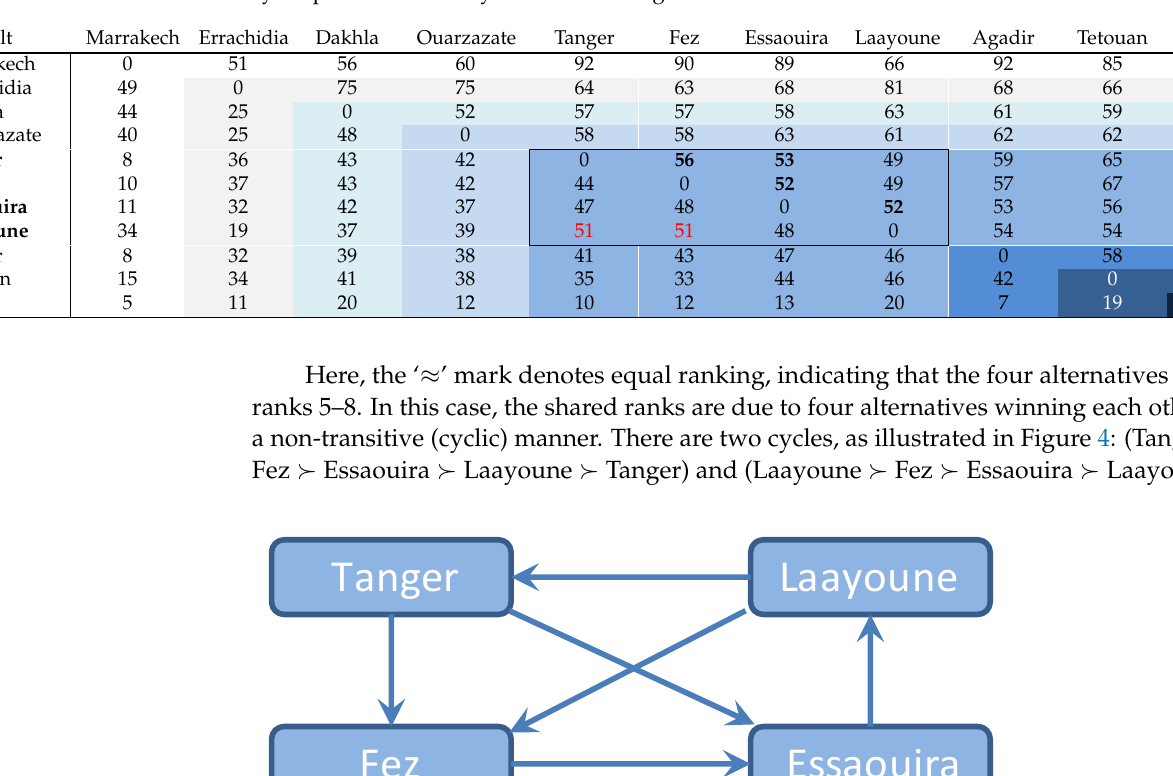
Table 4. Pairwise winning indices c ik for alternatives after first analysis based on 4 criteria. Partial ranking is formed based on c ik > 50%. Tanger, Fez, Essaoiura and Laayoune share ranks 5–8 due to cyclic pairwise wins. Cycles broken using the Ranked Pairs method are shown in red.